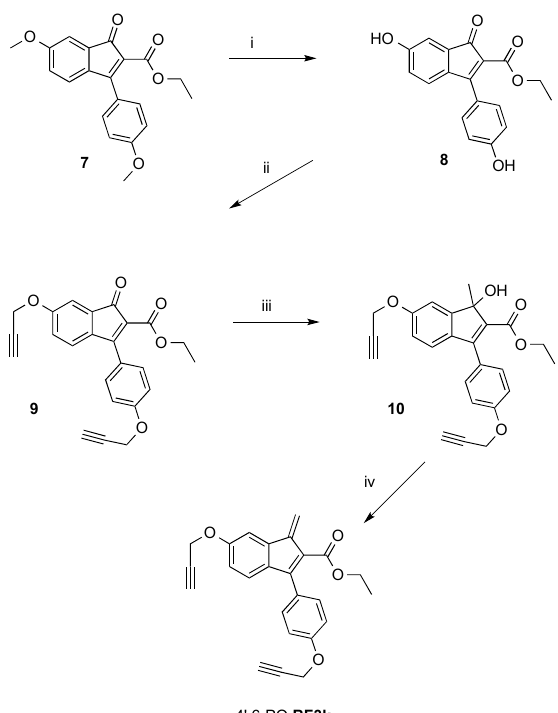
Scheme 3. Synthesis of benzofulvene monomer 4’,6-PO-BF3k. Reagents: (i) BBr 3 , CH 2 Cl 2 ; (ii) propargyl bromide, NaI, Cs 2 CO 3 , CH 3 COCH 3 ; (iii) Al(CH 3 ) 3 , CH 2 Cl 2 ; (iv) PTSA, CHCl 3 .